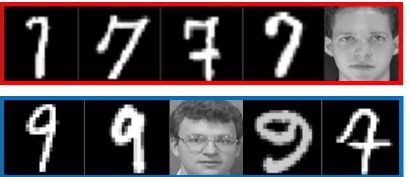
Figure 2. MNIST confused with a small number of ORL images .